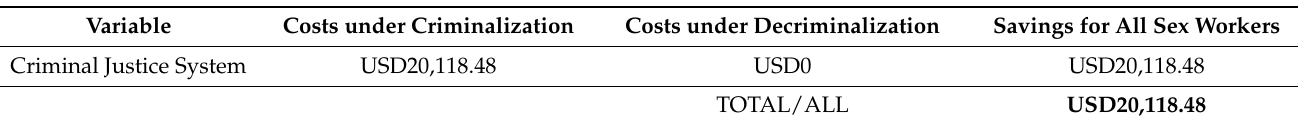
Table 13. Total annual criminal justice sector savings following decriminalization of sex work in DC (monetary values in 2020